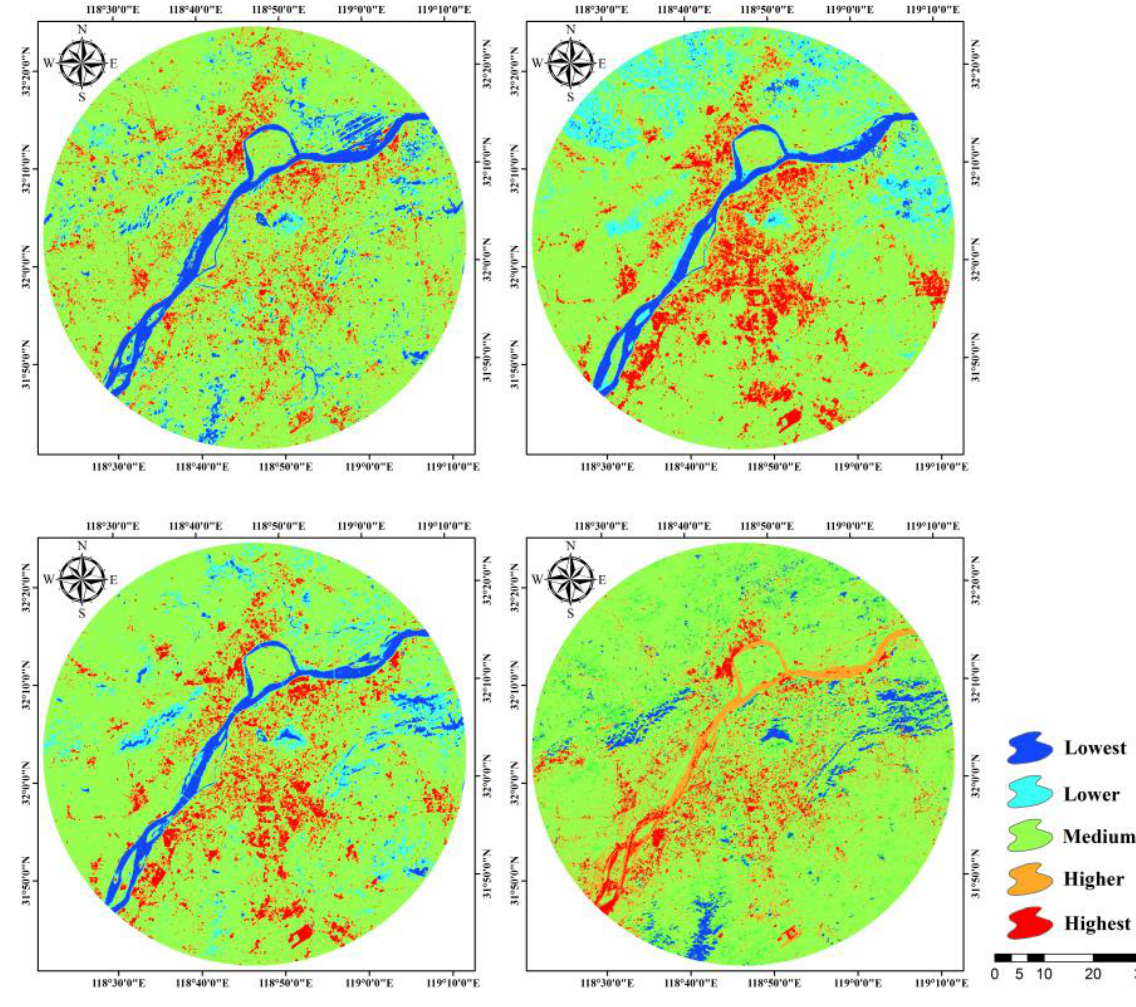
Figure 2. Land surface temperature of different seasons